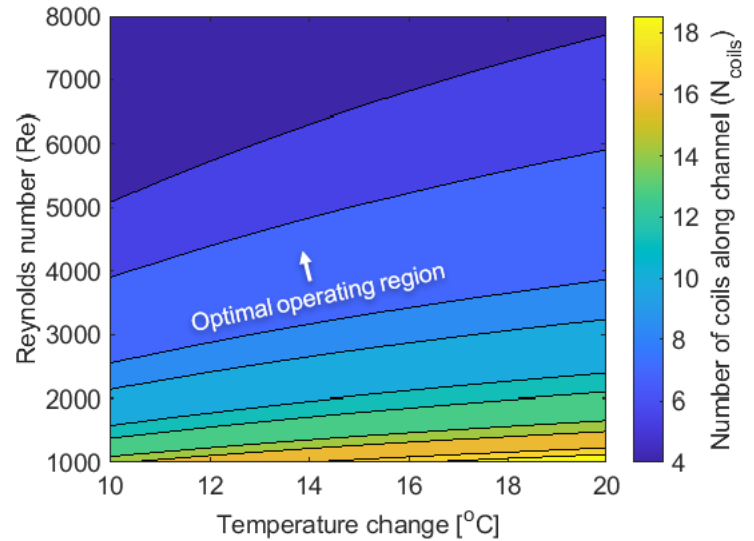
Figure 9. Number of coils required for cooling of air with respect to Reynolds number. T in = 27 ℃ , RH in = 70%, with H × W as 0.006 m × 1 m, h cs = 0.006 m. B = 5000 GPU. Transitioning from laminar to RH × W as 0.006 m × 1 m, h cs = 0.006 m. B = 5000 GPU. Transitioning from in = 70%, with H